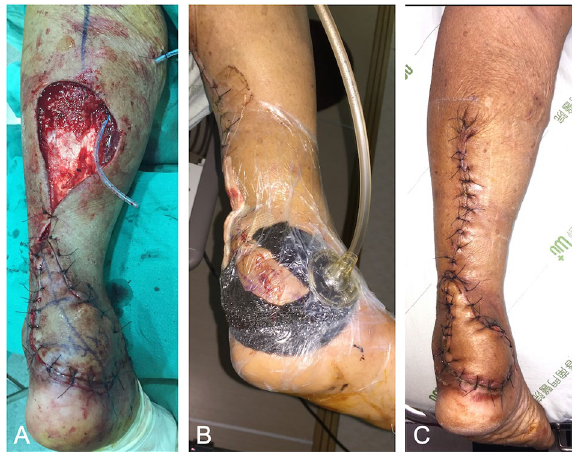
Figure 4. ( A ) A 6 × 8 cm defect over the left heel was covered with reverse sural flap. ( B ) NPWT was applied immediately following surgery, with an opening left to avoid compression of the pedicle from the posterior tibial artery. ( C ) On postoperative day 5, the NPWT was discontinued and the flap showed a well-circulated